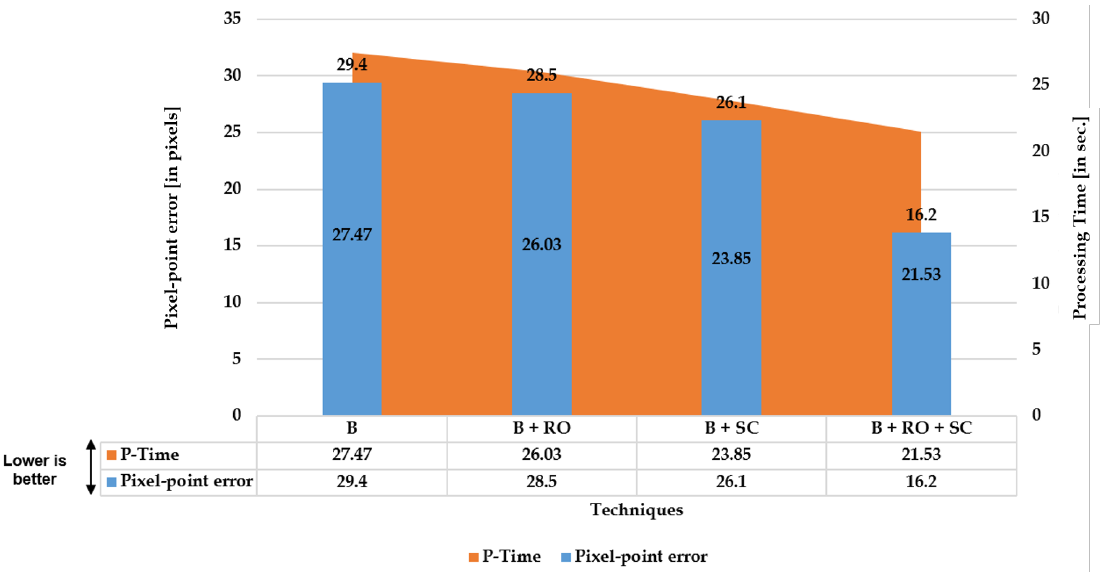
Figure 5. Quantitative: Significance of proposed cumulative set aggregation loss and refinement scheme with respect to pixel-point error and processing time on distortion center benchmark dataset.